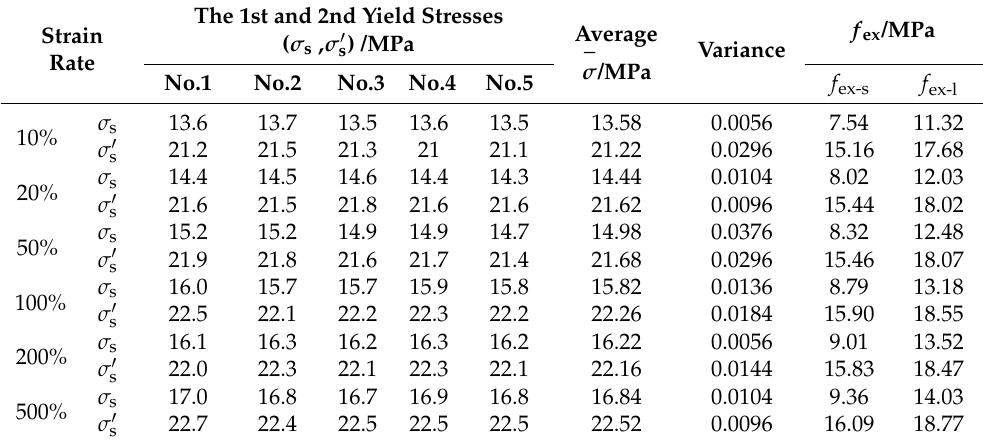
Table 6. The 1st and 2nd yield stresses ( 𝜎 (cid:2929) , 𝜎′ (cid:2929) ) determined by the existing design code. The 1st and 2nd Yield Stresses Strain Rate Strain